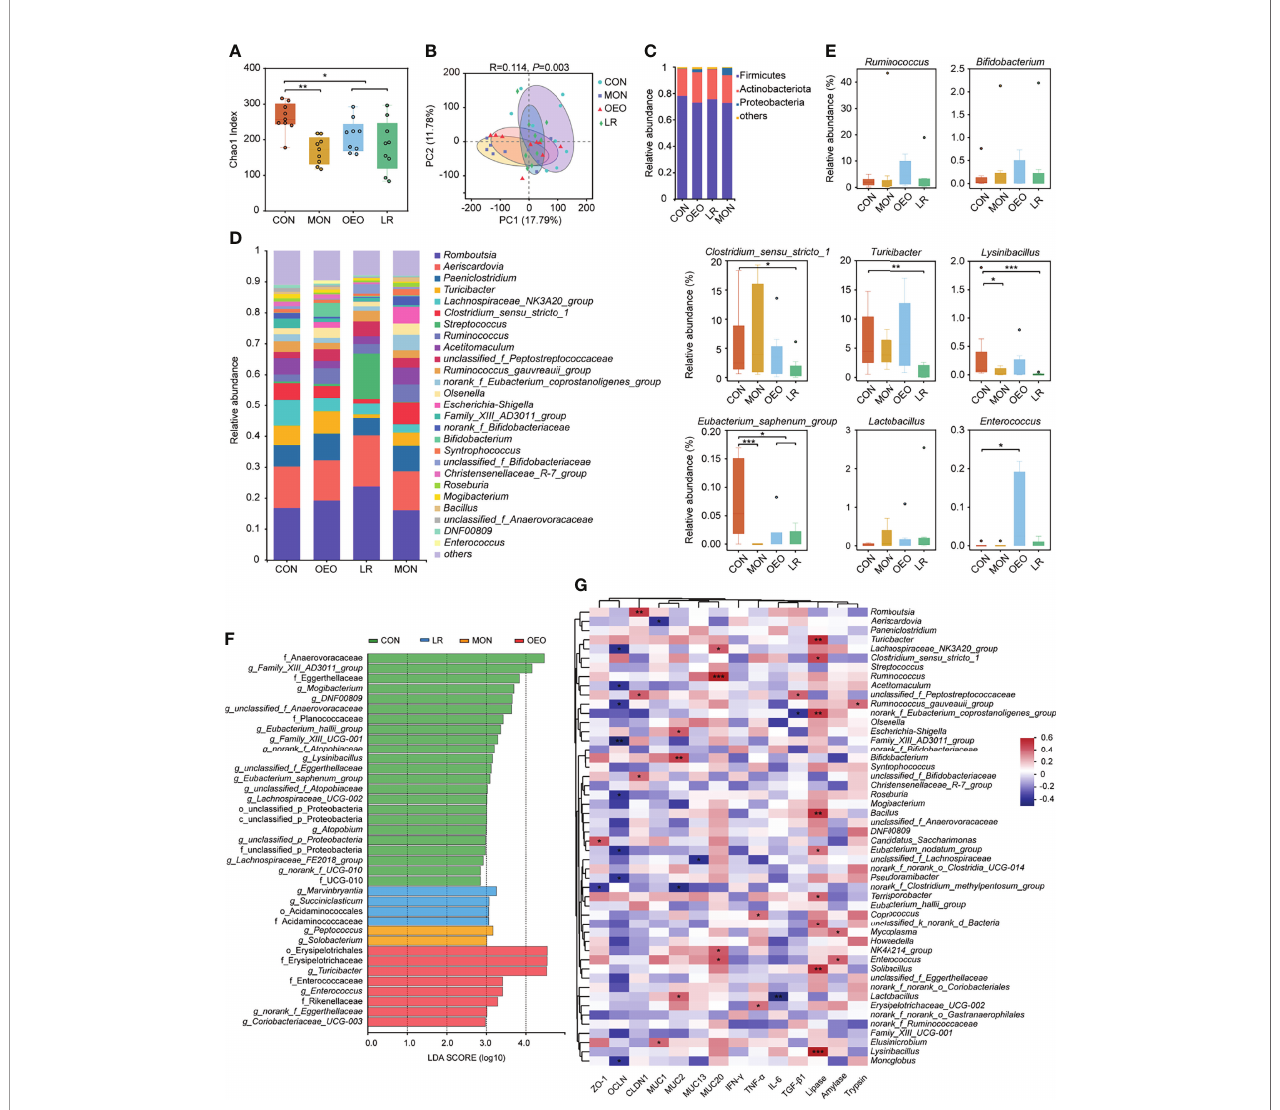
FIGURE 4 | Microbial diversity of the sheep ileum. (A) Alpha diversity as presented by Chao1 index in the ileum of sheep among groups. (B) Principal coordinates analysis (PCoA) of bacterial communities in the ileal contents of sheep (based on the binary-hamming method). The composition of ileum microbiota of sheep at phylum (C) and genus (D) level. (E) Box plots showing the differences of taxonomic groups at the genus level. Data was presented as median and whiskers represented the Tukey. The statistical method was the Wilcoxon rank-sum test. (F) Total bacteria in the ileum of the sheep which make contributions to the difference at the phylum, class, order, family, and genus levels, as analyzed by the LDA effect size (LEfSe) method. (G) Heatmap of Spearman ’ s correlation analysis between the ileum bacterial, digestive enzyme, in fl ammatory cytokines and barrier functions related gene expression. Red represents a positive correlation, while blue represents a negative correlation. CON, a basal diet; MON, a basal diet plus 0.5 g/head/d monensin; OEO, a basal diet with 52 mg/head/d oregano essential oil; LR, a basal diet supplemented with 10 g/head/d lactobacillus reuteri. Asterisks indicate signi fi cant difference between the trial group and the CON group (*0.01 < P ≤ 0.05; **0.001 < P ≤ 0.01; *** P ≤